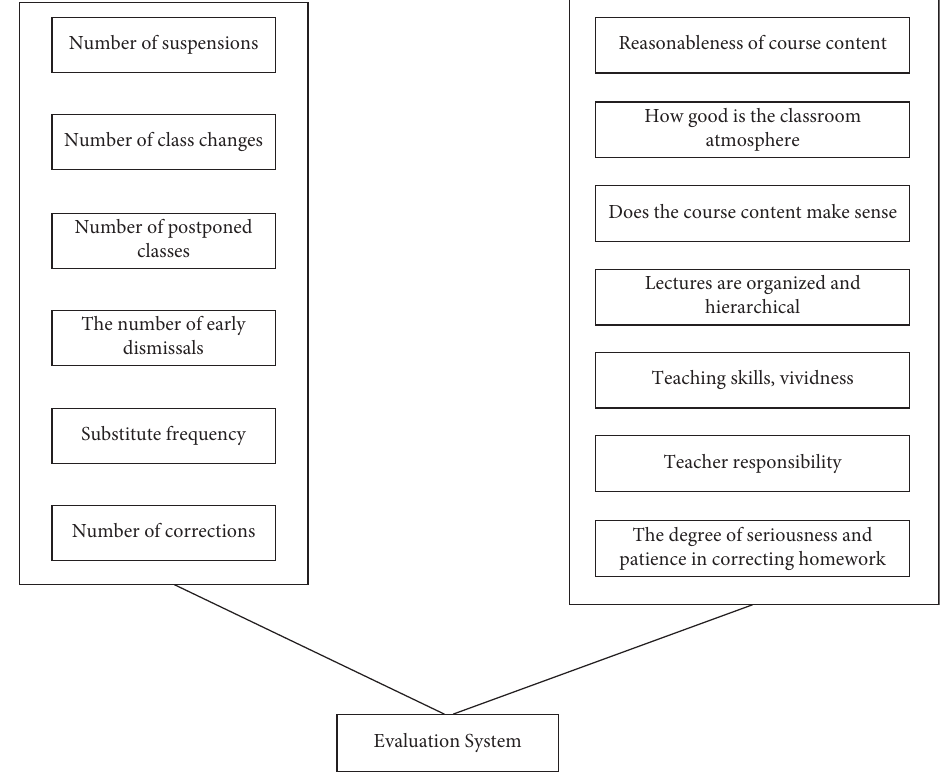
Figure 1: Evaluation index of English teaching